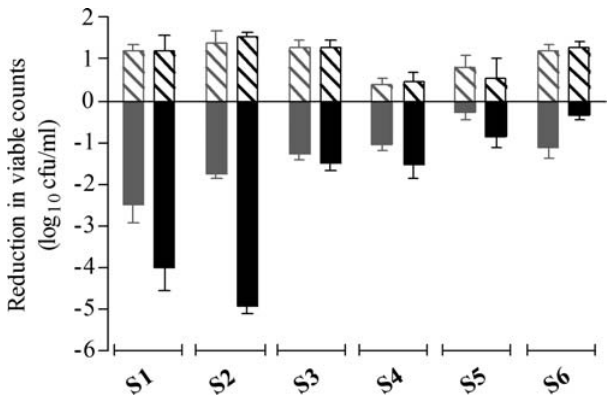
Figure 3. Mean changes in initial inocula at the end of dosing intervals: Decrease in log 10 cfu/ml initial inocula in antibiotic simulations at 12h (solid grey) and 24h (solid black); or increase in log 10 cfu/ml initial inocula in antibiotic-free simulations at 12h (grey diagonal stripes) and at 24h (black diagonal